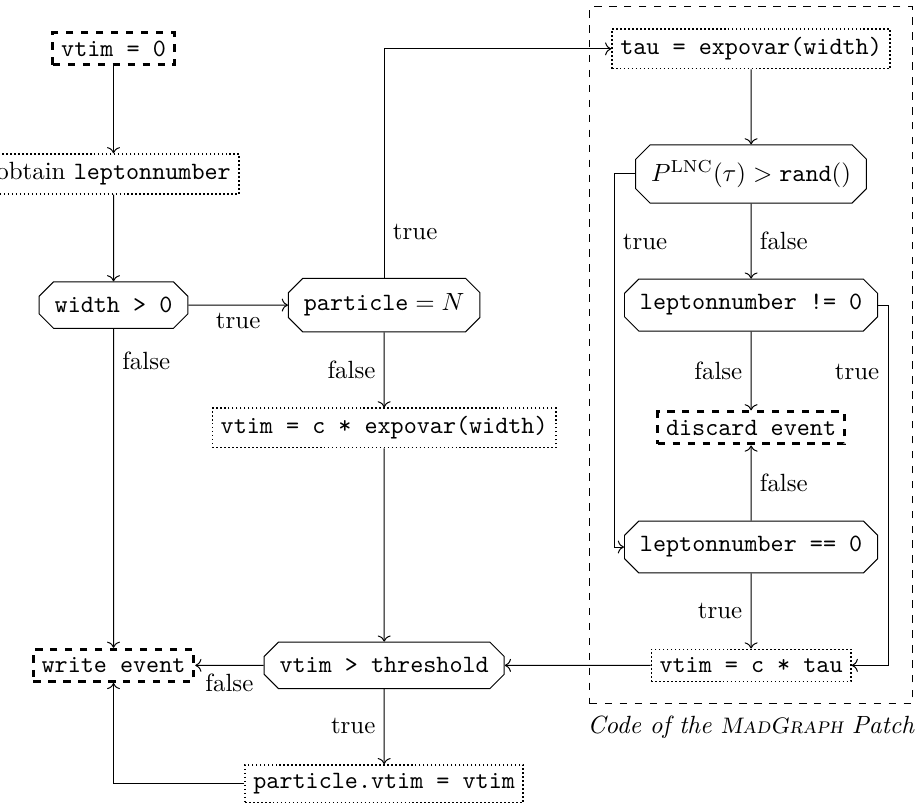
Figure 9 . Patched MadGraph routine assigning a proper TOF ( vtim ) in the presence of oscillations to a particle ( particle ). The process flows from the node vtim = 0 to the nodes write event and discard event